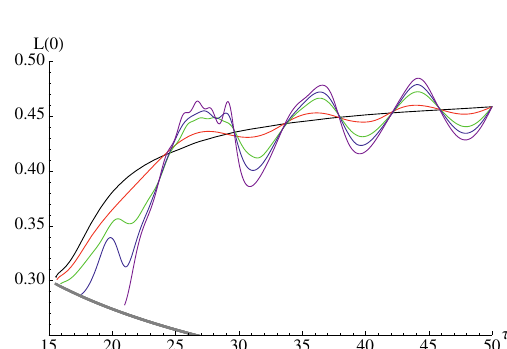
Figure 8. Plots of the IR position of the D7 brane against time for a number of large time initial conditions with di ff erent energy [6] . The thick black line is the